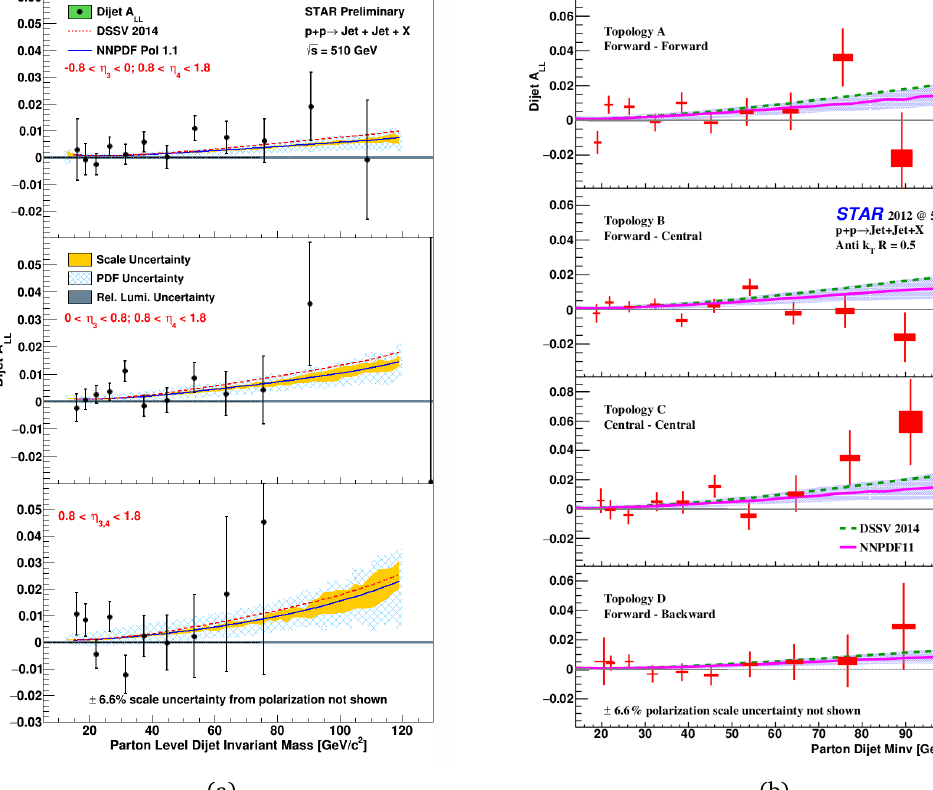
Figure 3: A as a function of parton-level invariant mass for dijets from 2012 LL STAR data at 510 GeV. Figure (a) presents the preliminary results obtained for the East Barrel-Endcap (top), West Barrel-Endcap (middle) and Endcap-Endcap (bot- tom) event topologies with statistical uncertainties only. Figure (b) presents results from [ 13 ] for different event topologies in Barrel calorimeter as described in the text. The error-bars show the size of the statistical uncertainties, whereas the boxes indicate the size of the systematic uncertainties. The curves represent theoretical evaluations of A for DSSV14 [ 2 ] and NNPDFpol1.1 [ 3 ] parton LL